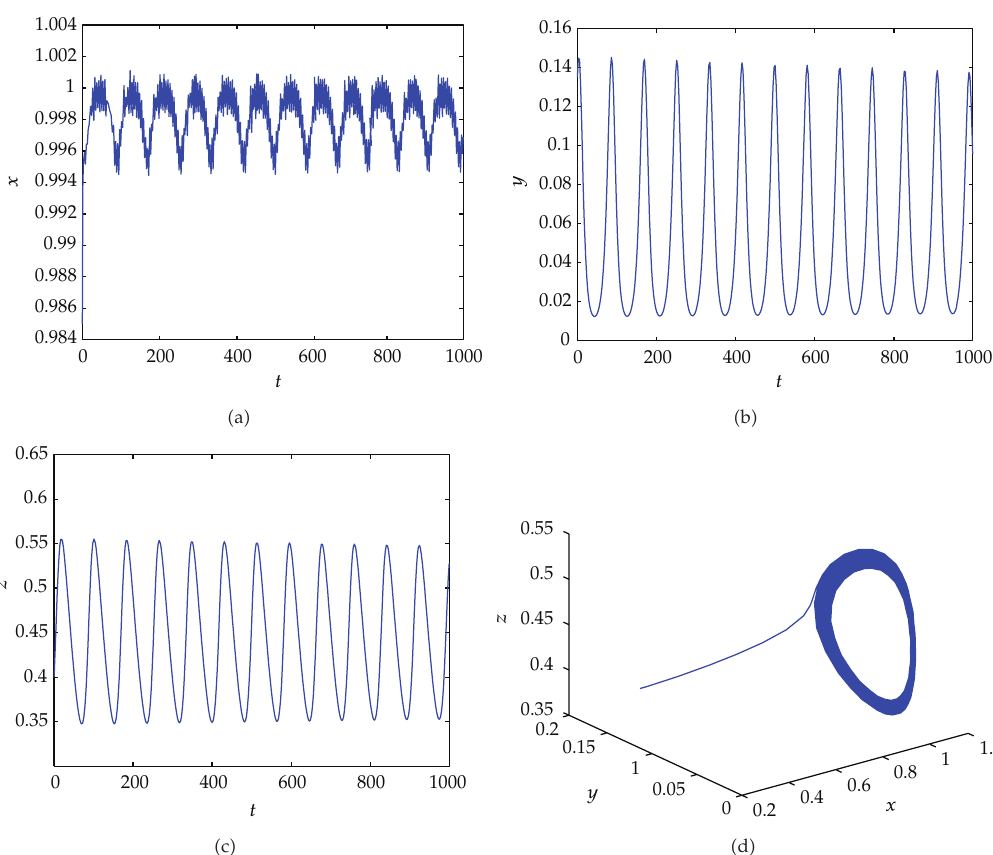
Figure 3: A stable periodic orbit of system (cid:6) 2.2 (cid:7) when initial value is (cid:6) 0.985, 0.135, 0.4 (cid:7) and τ (cid:8) 20 . 7288 > τ 0 (cid:8) 12 .